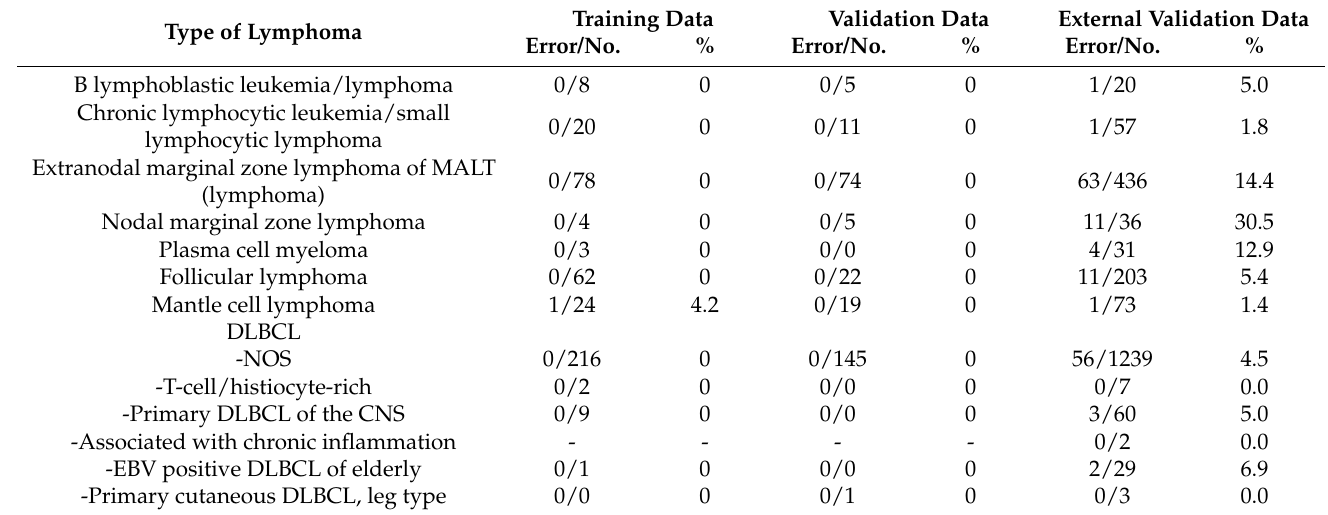
Table 2. Cases with discordant results between the original and predictive diagnoses in training, validation, and external validation